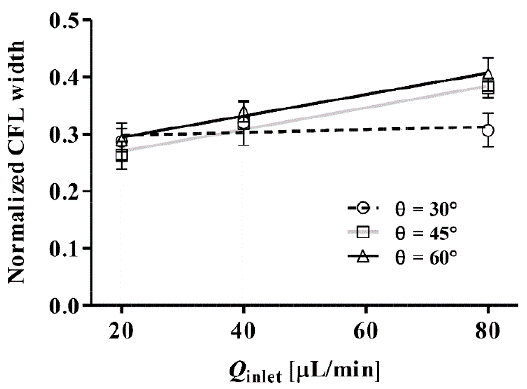
Figure 4. Effect of inlet flow rate ( Q inlet ) on the normalized CFL width with different angles ( θ ). The lines represent linear regression fits for each data set.